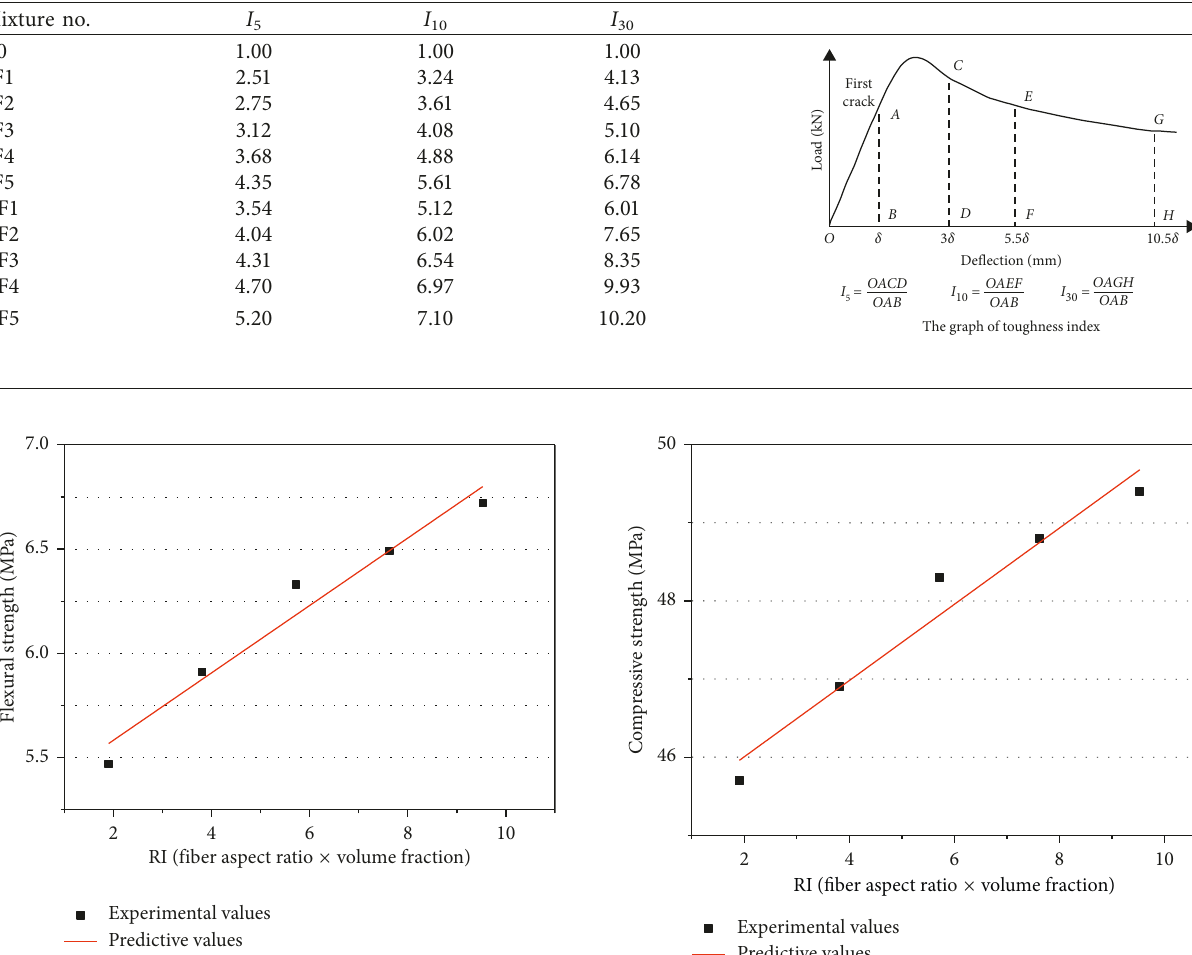
Figure 5: Comparison of predicted and experimental values of flexural strength.